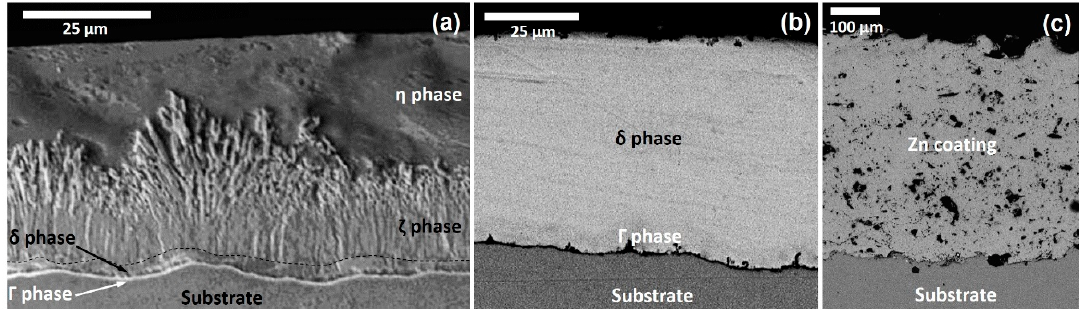
Figure 4. SEM micrograph of the cross section of the coatings deposited by hot-dip galvanizing ( a ), pack cementation ( b ) and thermal spray ( c ).